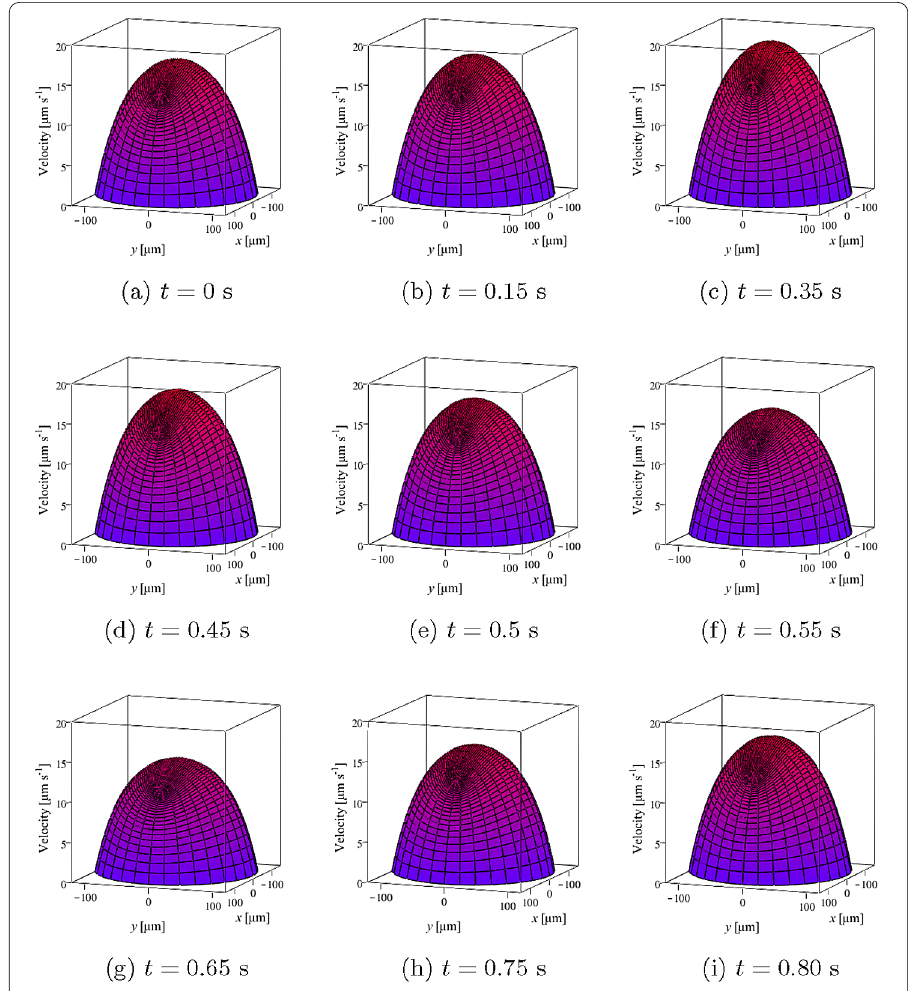
Figure 2 Velocity profiles with various times t = 0,0.15,0.35,0.45,0.5,0.55,0.65,0.75,and 0.8 s for l = 1 μ m, and E = 500 Vm –1 .